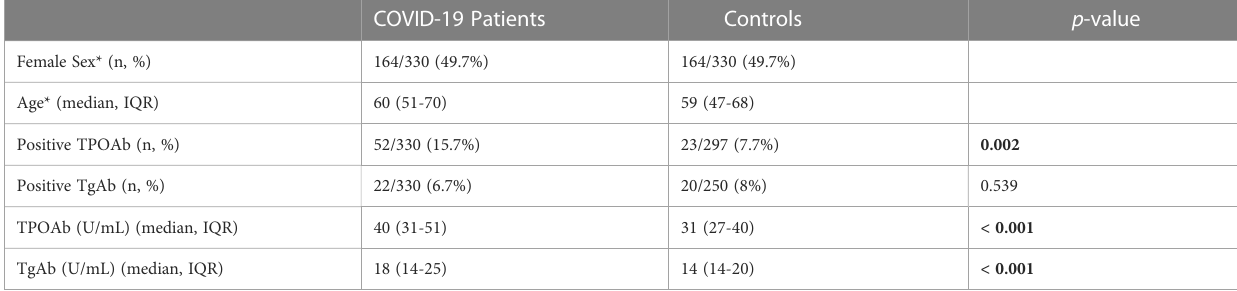
TPOAb, anti-thyroperoxidase antibodies; TgAb, anti-thyroglobulin antibodies. *Age and sex were matched in cases/controls for the sensitivity analysis. Bold values denote statistical signi fi cance at the p < 0.05